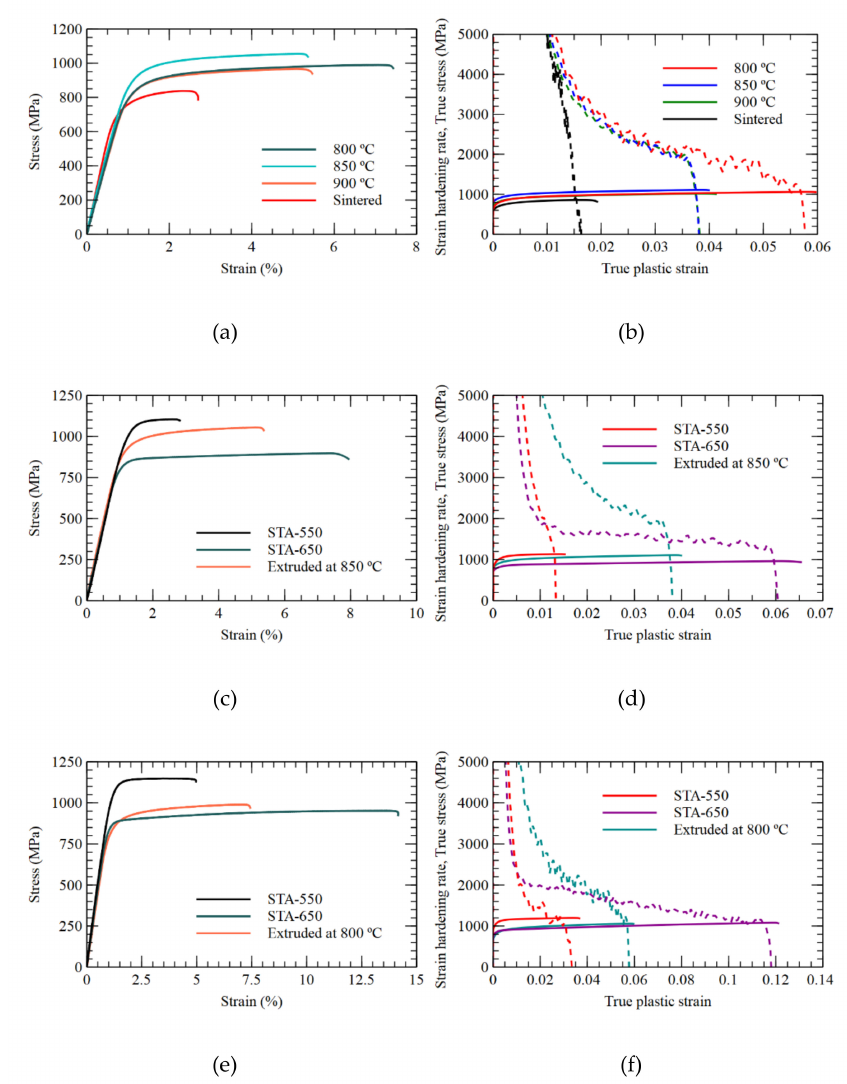
Figure 4. Tensile behavior of the PM Ti-5Fe alloys under di ff erent thermomechanical processing conditions: ( a , b ) e ff ect of extrusion temperature, ( c , d ) e ff ect of STA on the alloy extruded at 850 ◦ C, and ( e , f ) e ff ect of STA on the alloy extruded at 800 ◦ C. ( a , c , e ) stress–strain curves and ( b , d , f ) strain hardening